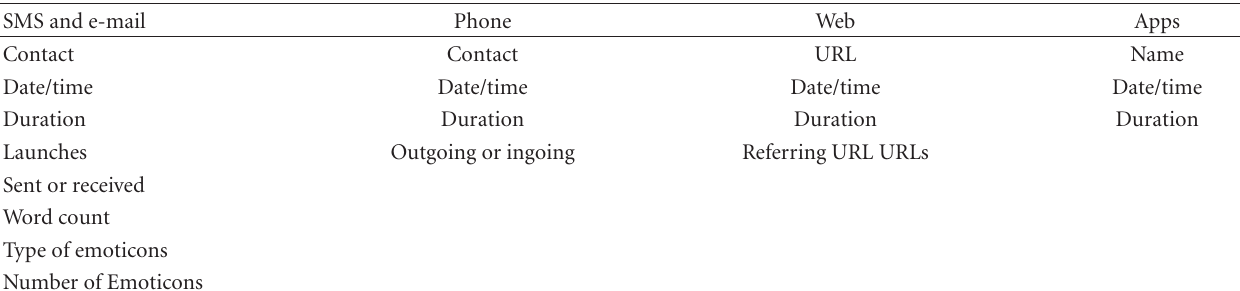
Table 2: Example of data that can be collected through